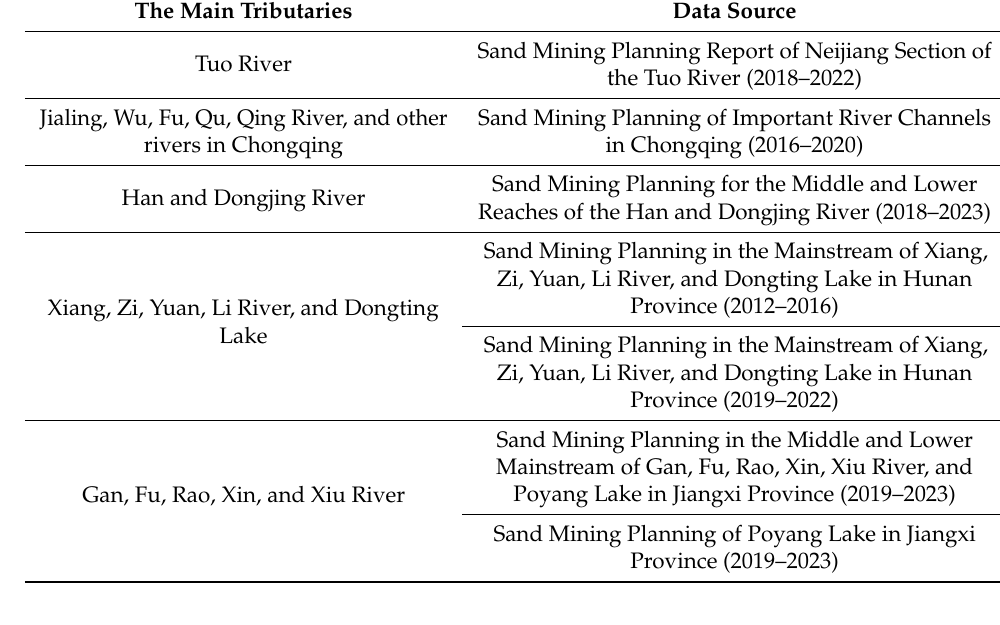
Table 1. The planned data source of sand mining in the tributaries of the Yangtze River (YR).